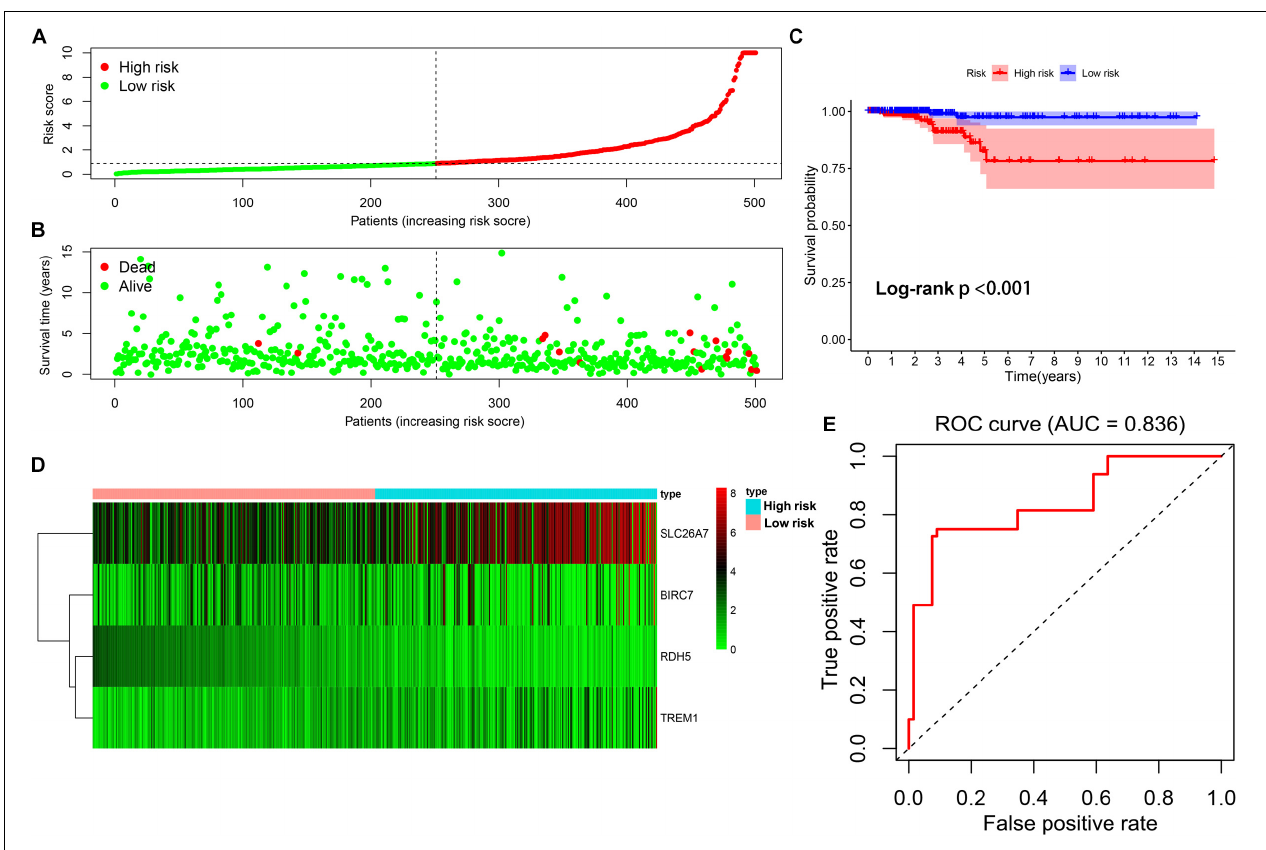
FIGURE 6 | Construction of the multi-gene prognostic signature. (A) The distributions of patients’ risk scores. (B) The distributions of risk scores and OS status. (C) The survival analysis of the two subgroups stratified based on the median of risk scores. (D) The expression pattern of the four methylation-driven genes in low- and high-risk groups. (E) The ROC curve for evaluating the prediction efficiency of the prognostic